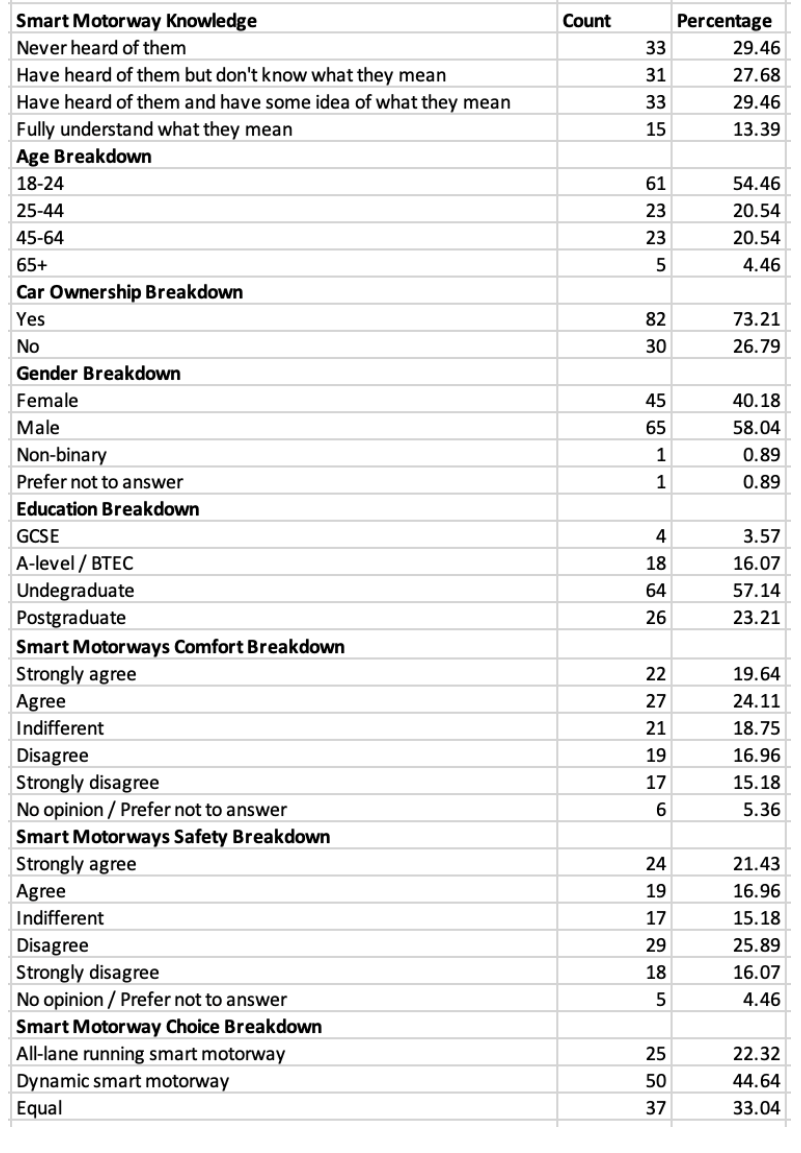
Figure 1 Frequencies of the entire